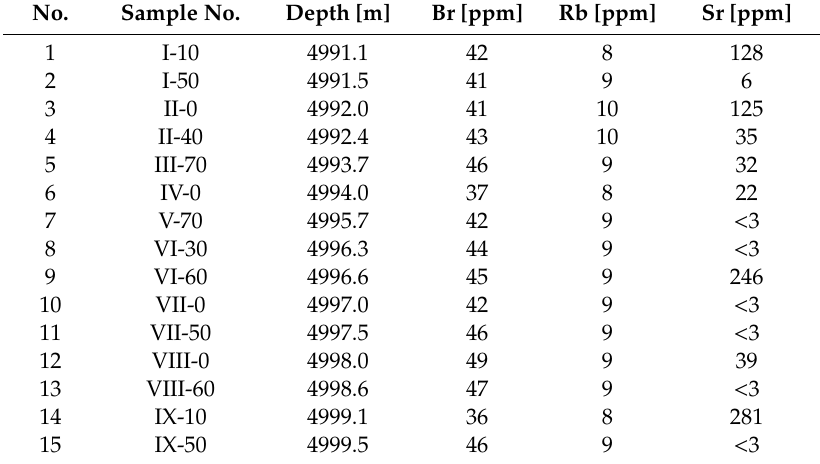
Table 1. Bromine, rubidium, and strontium contents in pure halite samples collected from the Huwniki-1 well. No. Sample No. Depth